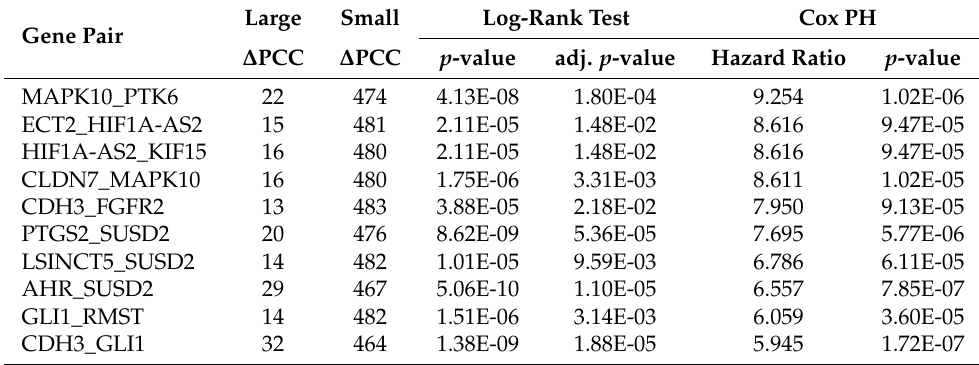
Table 2. Gene pairs with the highest hazard ratio in